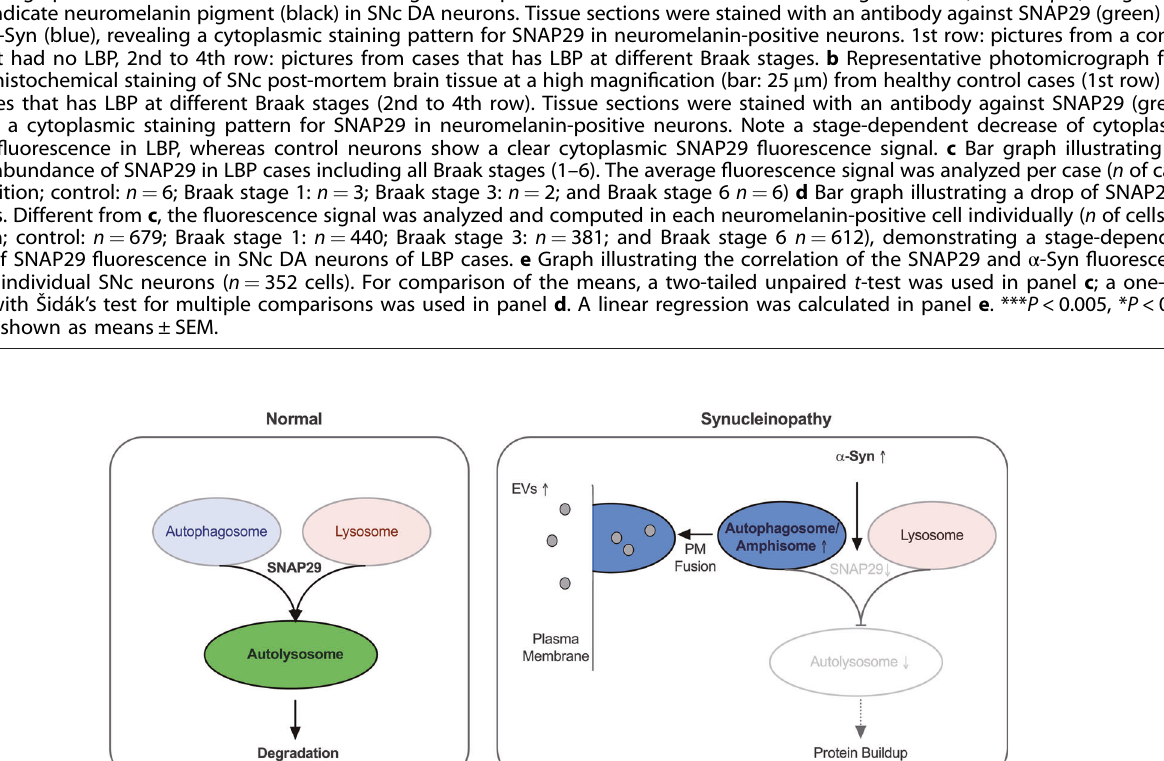
Fig. 8 α -Syn impairs autophagosome – lysosome fusion through SNAP29. Graphic summarizing the effect of α -Syn on autophagy turnover. α -Syn overexpression leads to a decreased abundance of SNAP29 which results in an attenuated fusion of autophagosomes with lysosomes. As a result, less autolysosomes are formed and the degradation of cellular materials may be impaired. In order to compensate for a reduced autophagic fl ux, autophagosomes fuse with the plasma membrane (PM) to release EVs into the extracellular